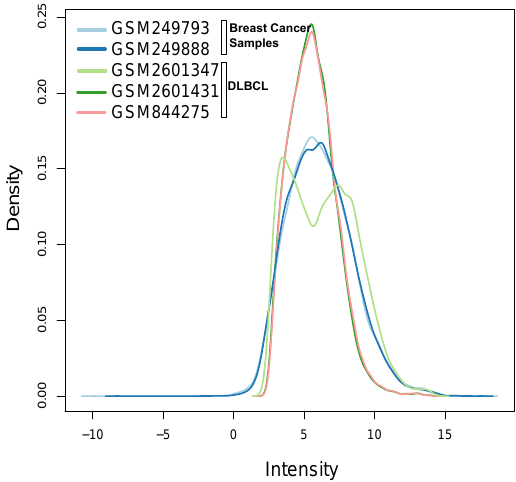
Figure 11. Outliers Density Plot of Dataset